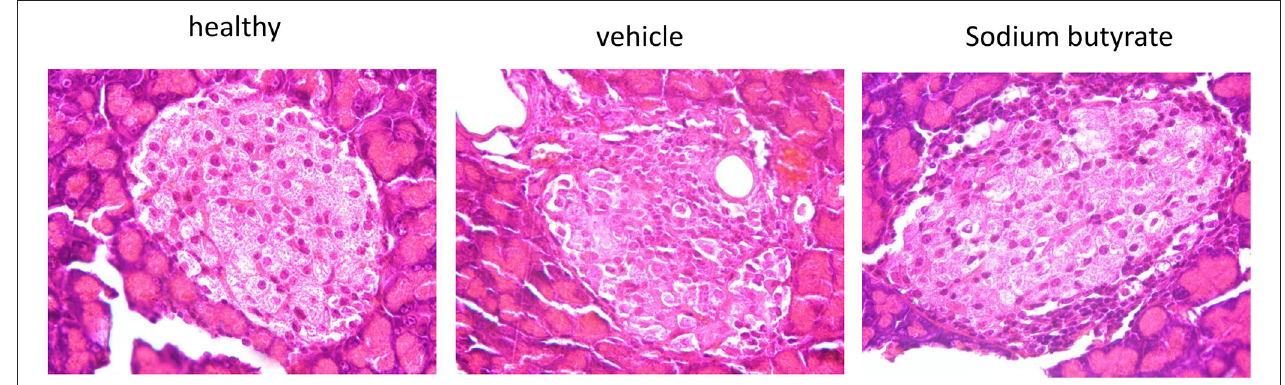
FIGURE 2 | Sodium butyrate treatment ameliorates the pancreatic histopathologic changes. Hematoxylin and eosin staining of pancreases from healthy mice, vehicle group, and sodium butyrate treated mice (H&E staining, magnification 1000 ×